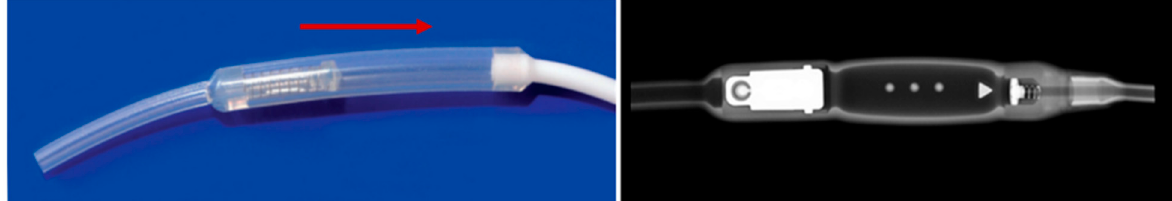
Figure 6. ( Left ). The Chabbra TM “slit n’ spring” valve (Surgiwear Limited, Shahjahanpur, India) is a design based in the slit valve. In this case, the silicone tube within the flushing reservoir in which the slit seat is protected by a stainless-steel spring. The red arrow indicates the direction of the flow. ( Right ). Radiograph of a Codman–Hakim TM Precision low-medium DPV (Integra LifeSciences Corporation). This DPV is a conventional mechanical spring-loaded ball-in-cone valve. The three dots indicate the OP of the valve and the short arrowhead the direction of the flow.